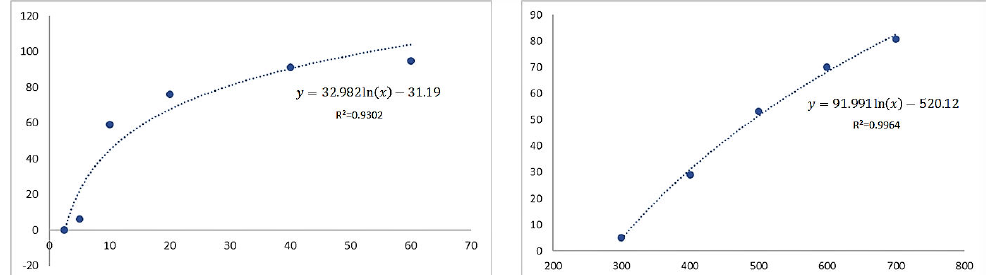
Figure 1. The effects of benomyl ( a ) and valerenic acid (VA) ( b ) on cell viability inhibition according to the 3-(4,5-dimethylthiazol-2-yl)-2,5-diphenyltetrazolium bromide (MTT) test